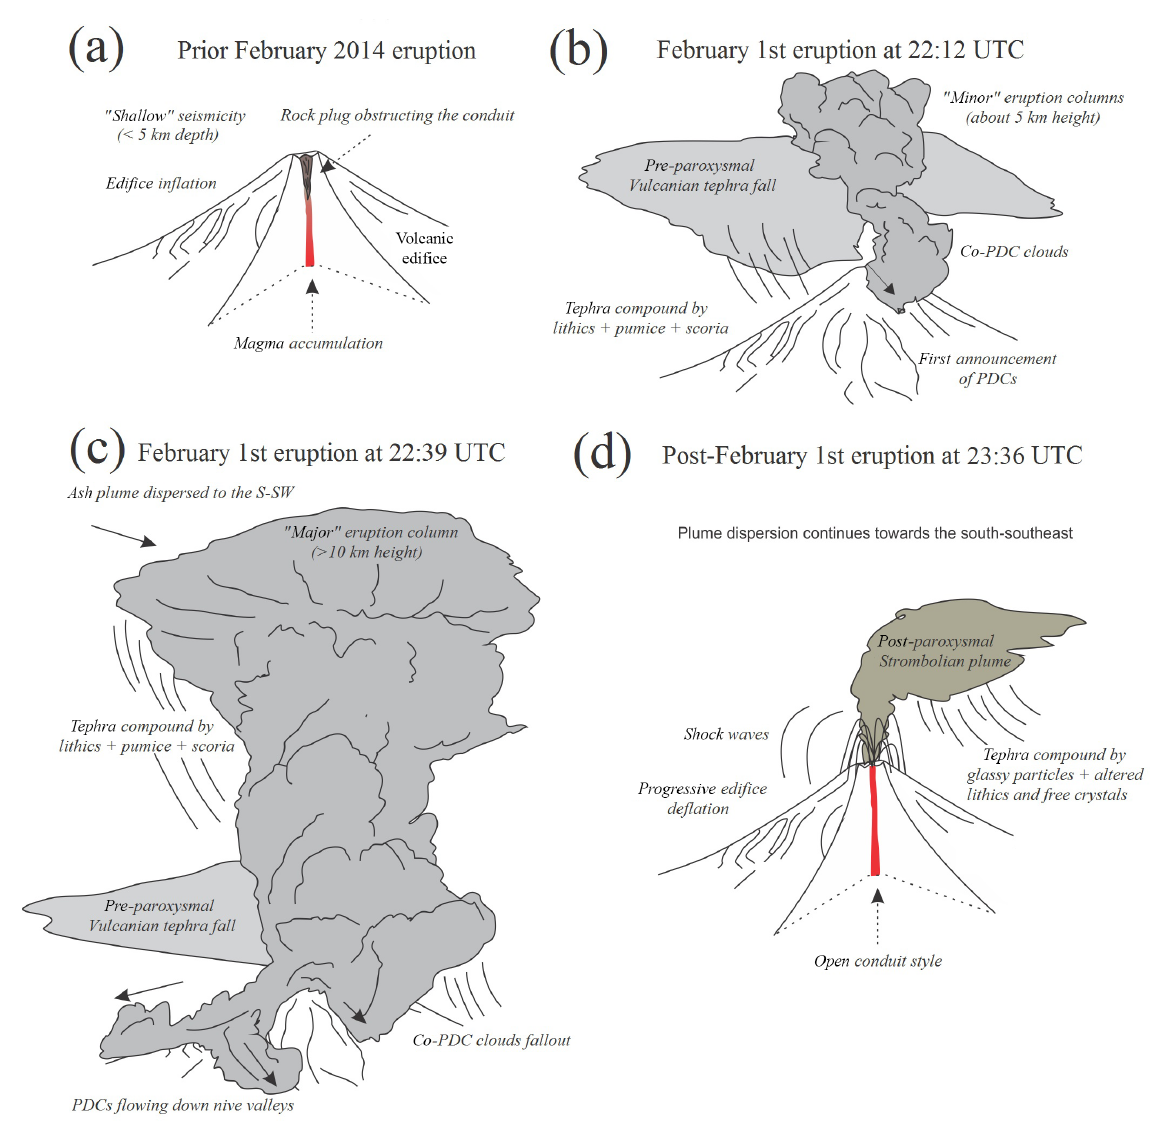
Figure 10. Dynamics of the February 2014 eruption at Tungurahua. (a) Pre-eruptive condition interpreted as plugging of the upper conduit. Fluid circulation cause alteration in the wall rock. The ascent of magma generates edifice inflation, and seismicity occurs only briefly before plug destruction due to faulting by overpressure. (b) The partial opening of the system generates small Vulcanian explosions and PDCs. (c) A major Vulcanian eruption with formation of a stratospheric column results from the total failure of the plug. PDCs descend the valleys on the flanks, transporting plug blocks, juvenile bombs and previously erupted material. (d) After the explosive paroxysm ends, the depressurisation of the volcano causes deflation and activity continues with an open-vent system with Strombolian activity. The juvenile magma is released with scarce content of